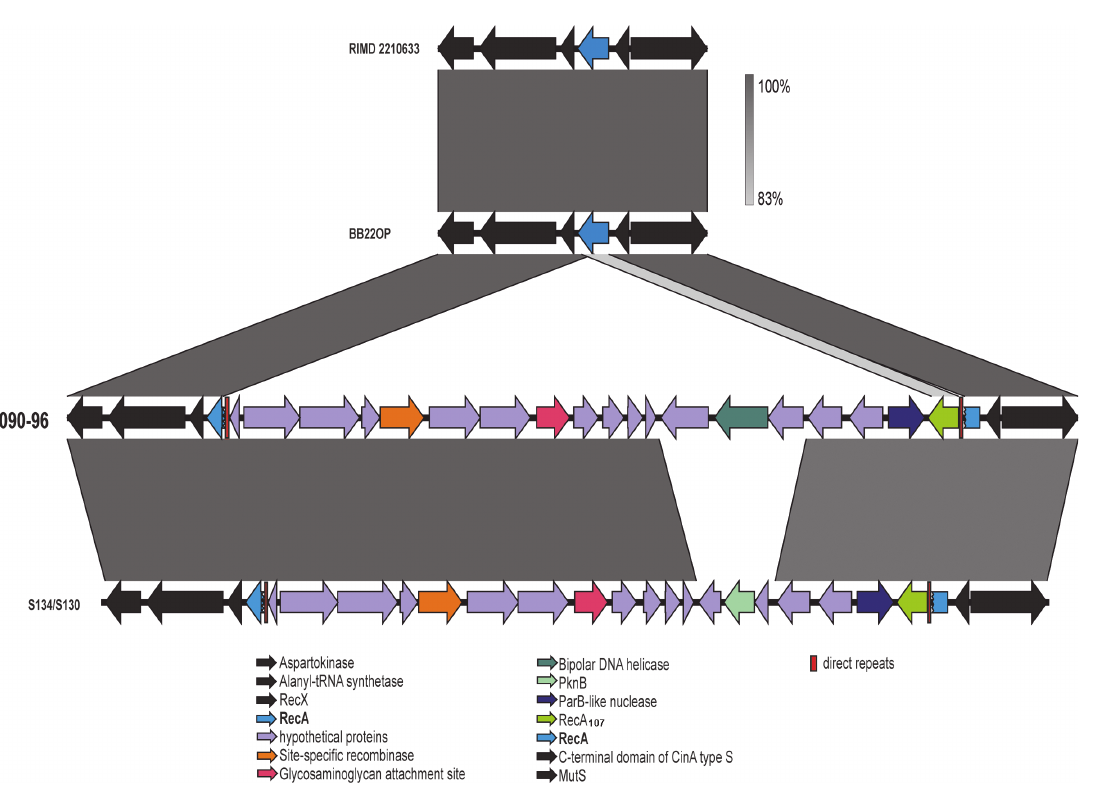
Fig 2. Schematic representation of the recA gene region between four V . parahaemolyticus genomes. Comparison includes RIMD2210633 (prototypic “ pandemic ” strain O3:K6), BB22OP (closest relative ST88), strains 090 – 96 (Peruvian, fragmented recA gene), and S134 (Chinese strain containing a similar insert at recA gene). Predicted genes are depicted by horizontal arrows and named according the legend. Red bars represent inverted regions flanking the insertion. The percentage DNA sequence identity is indicated in grey bars and represents the BLASTn matches between sequences.